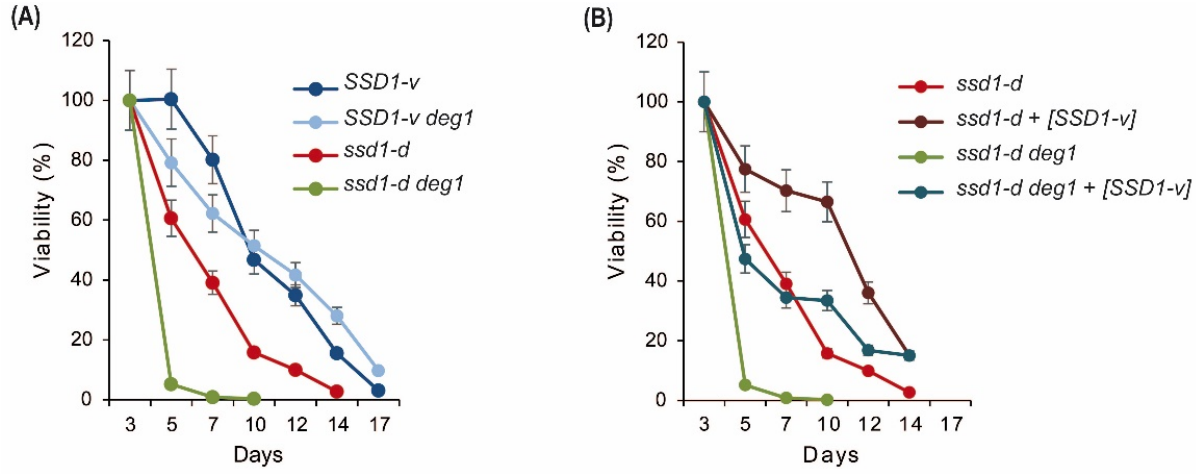
Figure 6. Influence of SSD1 and DEG1 on chronological aging. ( A ) Chronological aging was analyzed for the SSD1-v WT and the ssd1-v deg1 mutant in comparison to the ssd1-d and ssd1-d deg1 strains over a time range of 17 days. Viability (%) represents the determined colony forming units (CFU) per ml normalized to the respective value at day 0. The mean of three independent cultures and the standard deviation is given. ( B ) As in ( A ) but with indicated strains in the presence or absence of plasmid-based SSD1-v [ SSD1-v ].